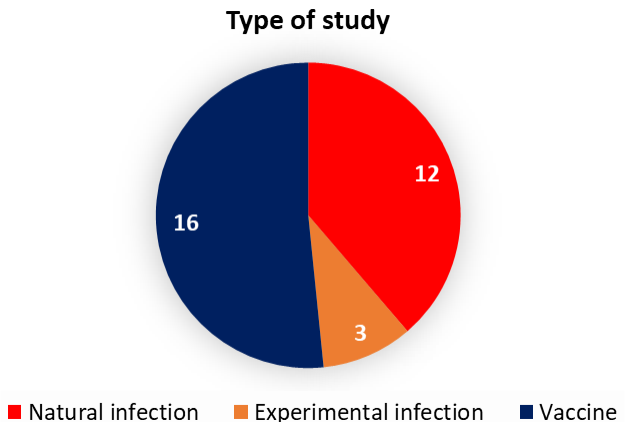
Figure 1. Break down of the dataset collection by category. The pie chart indicates the type of studies carried out for the 31 datasets.